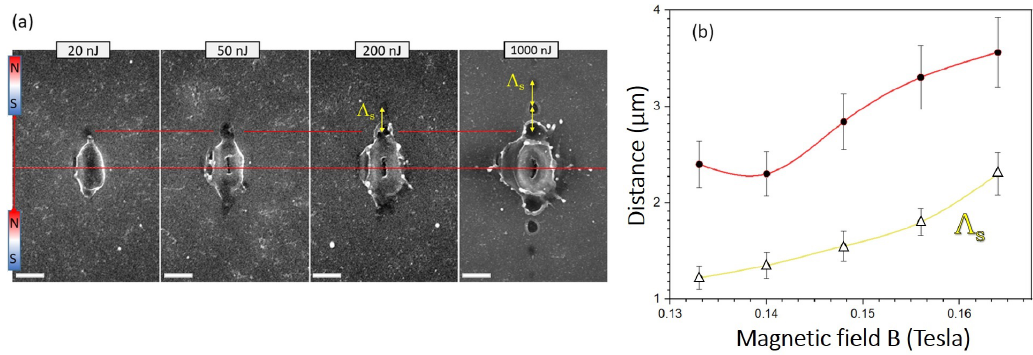
Figure 5. ( a ) SEM images of single pulse ablation sites at different pulse energies E p (at the entrance of the objective lens of numerical aperture NA = 0.7; transmission of the lens was T = 0.22). The gap x = 2.5 mm; B = 0.156 T. Scale bars = 2 µ m. The arrow markers are the same length of 1.75 µ m, for comparisons between ablated pits formed by different pulse energies. ( b ) Period Λ s (yellow/lower curve) versus magnetic field strength (or the gap width x ) at high pulse energy E p = 1.13 µ J; distance between the ablation centre and first micro-ablated pit (red/top curve) versus B . Lines are eye-guides; error bars are